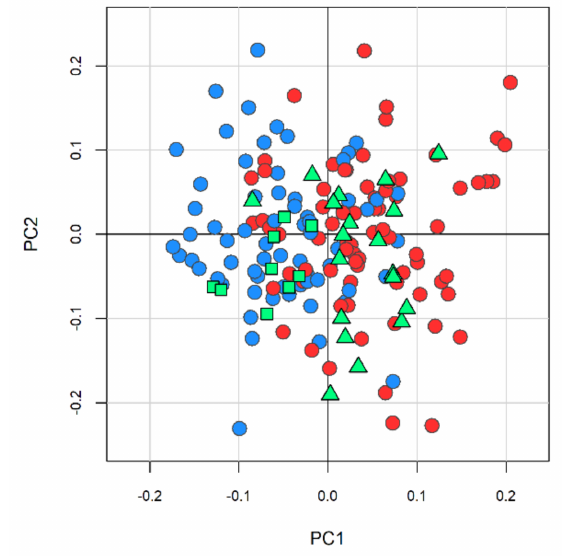
Figure 3. Prediction of cancer relapse using the NMR metabolomic fingerprint. The model calculated on NOESY1D spectra, discriminating patients free from eCRC disease relapse (light blue, dots, n = 65) and patients with mCRC (red dots, n = 75) using the PCA-CA-kNN analysis, was used to classify patients who developed disease recurrence. Twenty (green triangles) out of 29 patients were correctly classified as “metastatic” disease, the other nine patients (green squares) were mis-classified as early disease. This model provides an overall prediction accuracy of